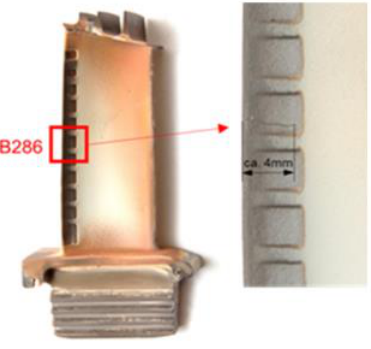
Figure 32. Turbine blade (B286) with a crack on the trailing edge.